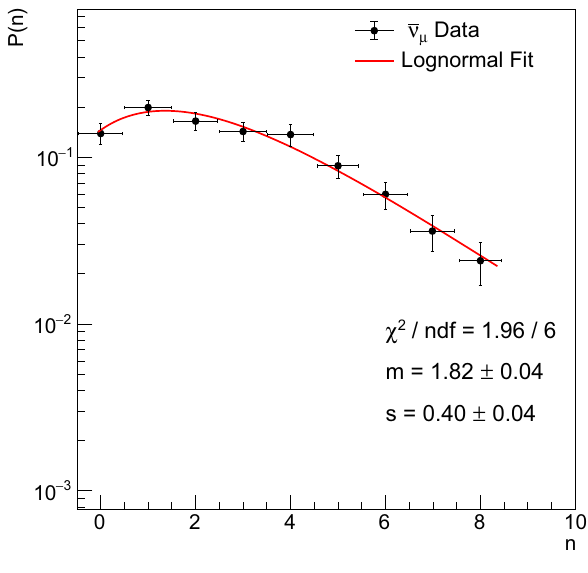
Fig. 2 The log-normal fit(solid line) of ¯ ν μ data Table 2 Fit parameters obtained from Log-Normal fit